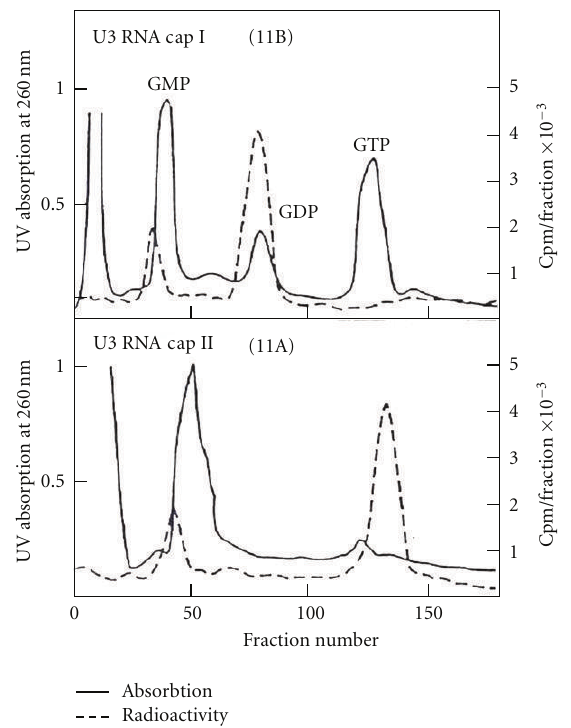
Figure 31: U3 RNA cap I and cap II chromatography [58]. The 5 (cid:2) fragment from Figure 29 was eluted and treated with alkaline phosphatase and chromatographed on DEAE-Sephadex A-25 with standards of GMP, GDP, and GTP. Component “11B” was eluted in the GDP (cap I, m 32,2,7 GpppAmA) region and “11A” (cap II, m 32,2,7 GpppAmAmA) was eluted in the GTP